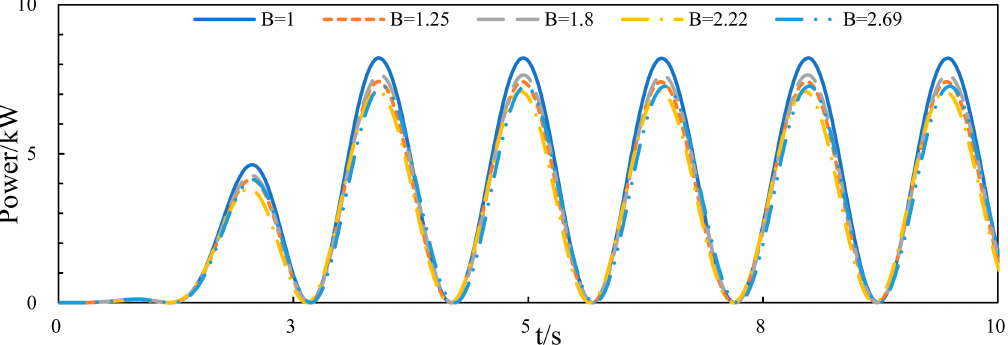
Figure 7. The instantaneous power curves of Buoy 2.